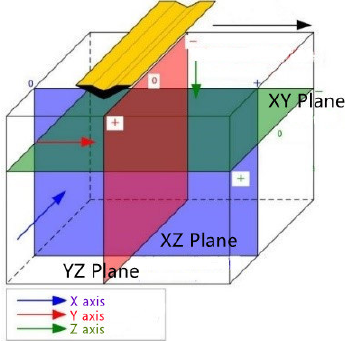
Figure 3. Three slicing methods for 3D ground-penetrating radar data.